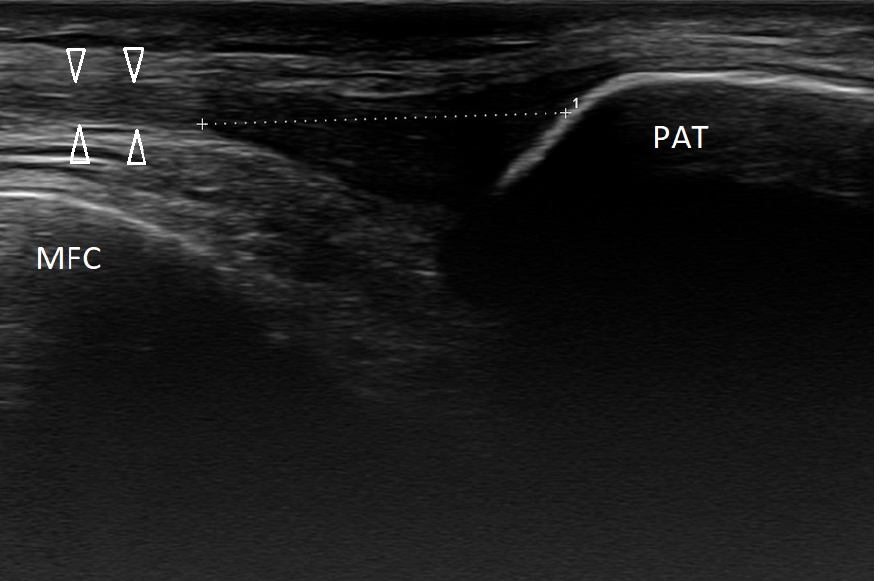
Figure 11. Hypoechoic scar formation (dotted line) in the medial patellofemoral ligament (MPFL) of the left knee joint. Probe placed along the course of the MPFL. Arrowheads—intact part of the MPFL. MFC—medial femoral condyle. PAT—patella. Linear probe 3–12 MHz.